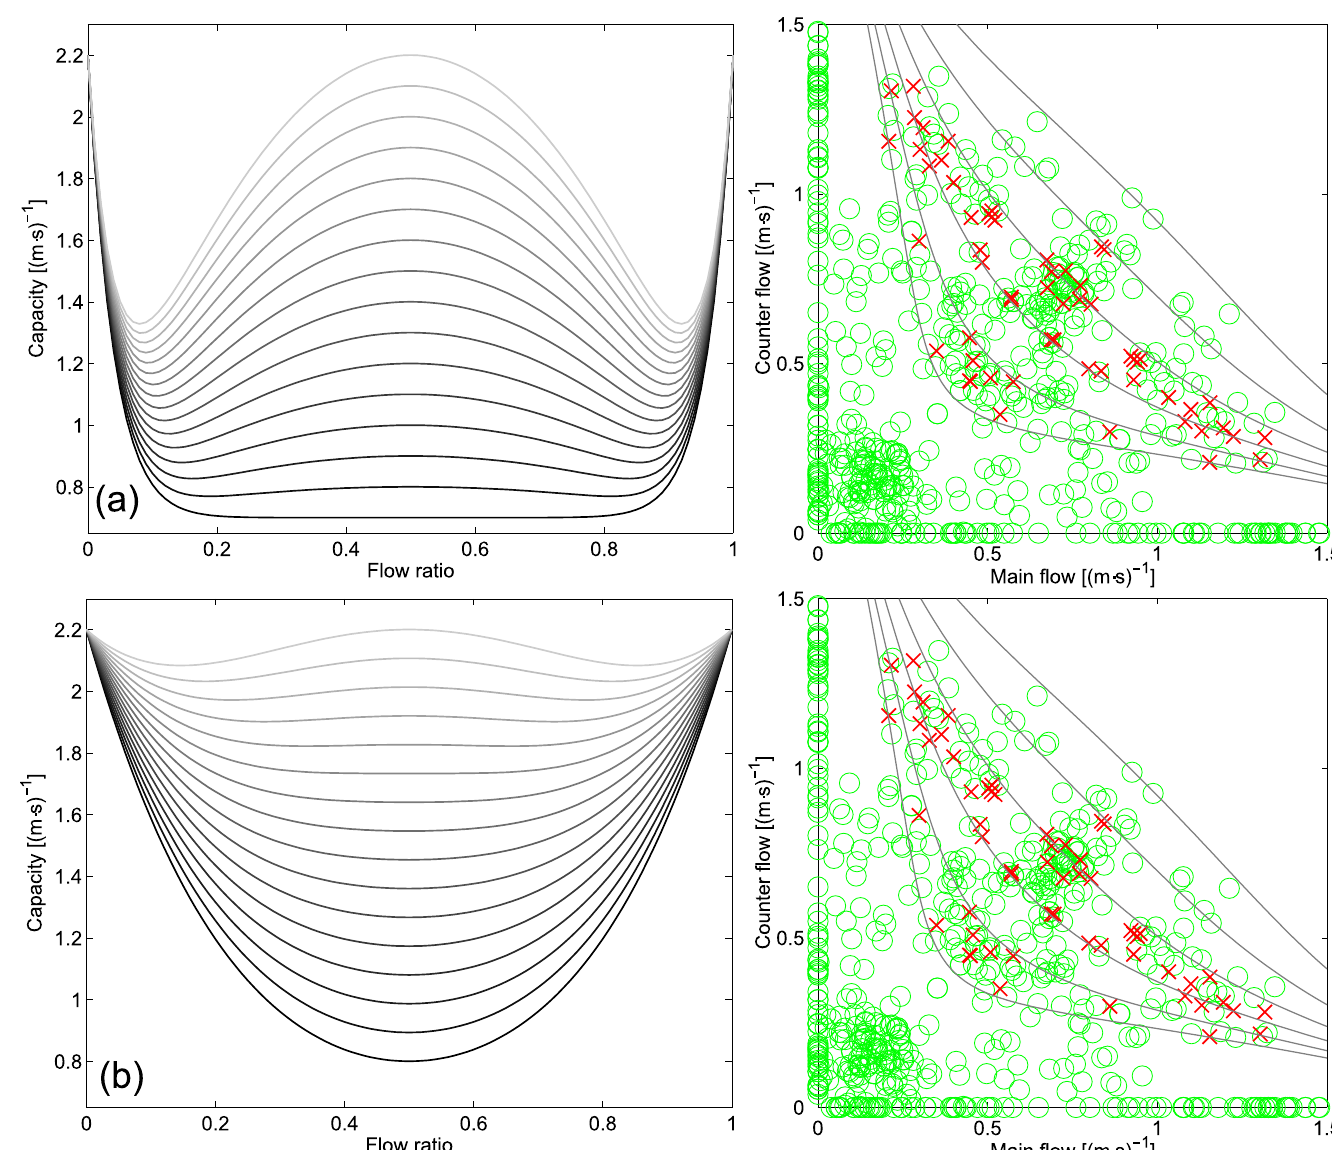
Fig 16. Transient capacity function and ability to depict transition to congestion. In the right side congested areas are given using red crosses, non-congested with green circles. In (a) a threshold of 1.00 m − 1 for the relative rotation range is used to define congestion, in (b) the threshold is 3.00 m − 1 . Parameters used in the equations are: n = 25, q = 0.75 (m � s) − 1 and q = 2.2 (m � s) − 1 for (a) and n = 5, q = 0.80 (m � s) − 1 , q = 2.2 (m � s) − 1 . In the graphs on the left τ is varied from 0 to 1 min max min max (0 being the darkest line and 1 the lightest).